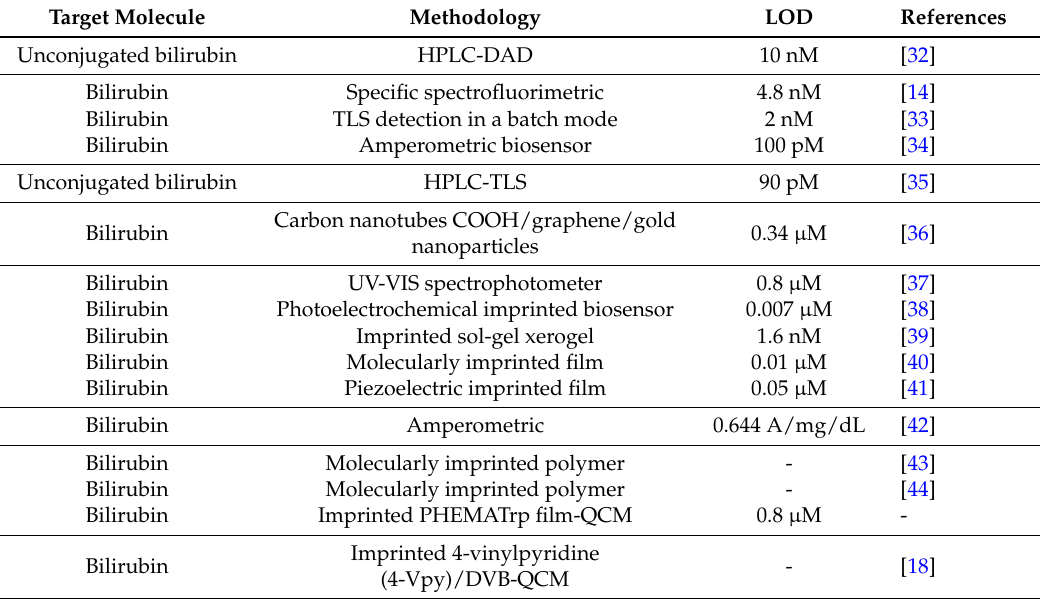
Table 2. Comparison of various bilirubin detection methods.